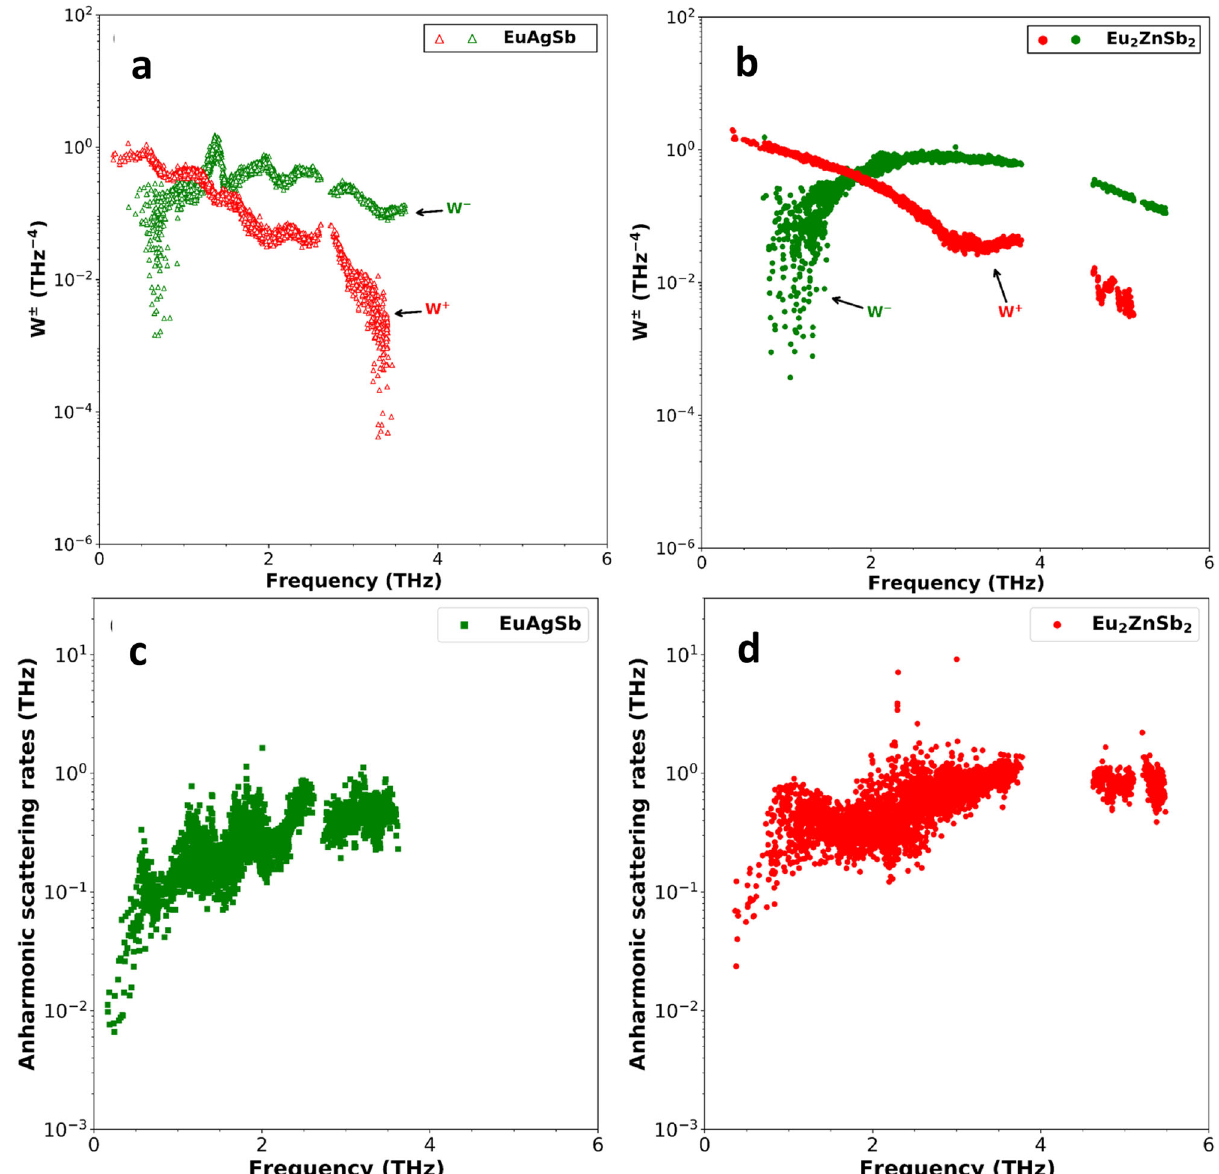
Fig. 6 Scattering phase space and scattering rates as a function of phonon frequency. This is the phase space for different phonon modes of a zig-zag structure EuAgSb and b Eu 2 ZnSb 2 . The + (-) sign represents three-phonon absorption (emission) phase space. The calculated anharmonic scattering rates for c EuAgSb and d Eu 2 ZnSb 2